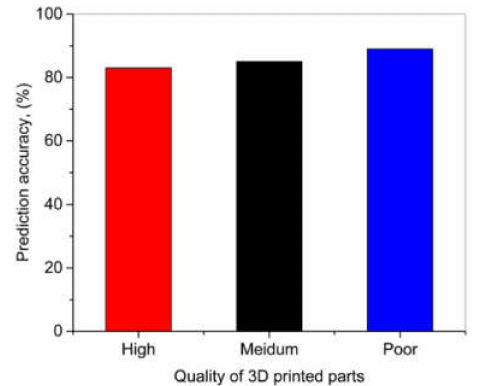
Figure 10. Prediction accuracy for high-, medium-, and poor-quality 3D-printed parts; based on the data from [73,74].